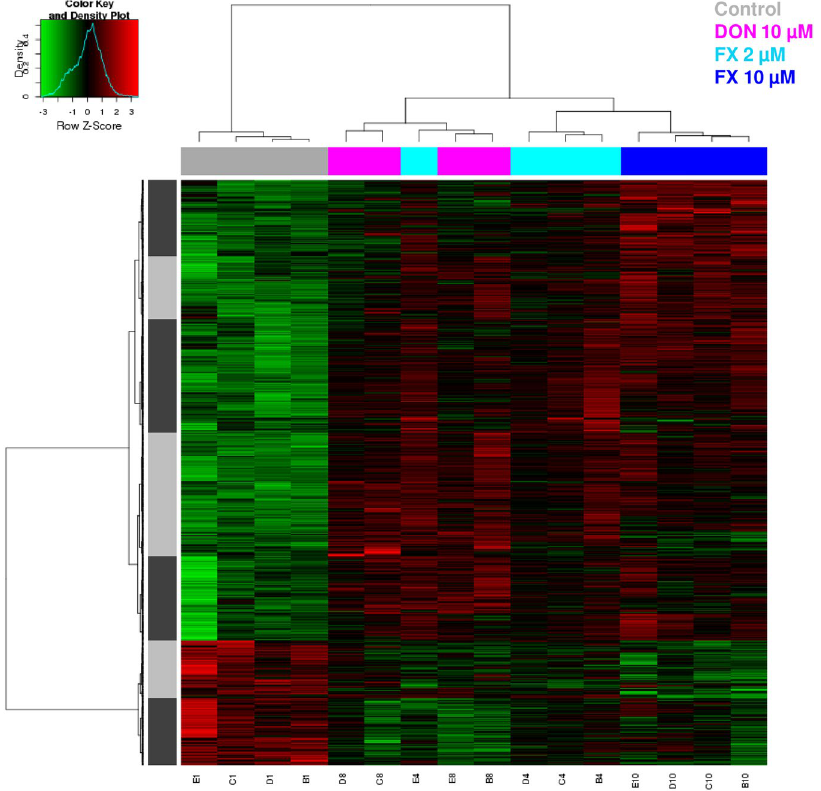
Figure 3. Gene expression profiles of intestinal explants exposed to DON or FX. Heatmap representing differentially expressed probes between the control, DON, and FX conditions. Jejunal explants from 4 different animals were exposed for 4 hours to DMSO (vehicle), 10 μ M DON (as a benchmark for the toxicity of TCTBs), or 2 or 10 µ M FX. Gene expression was analyzed with a 60 K microarray. Red and green colors indicate values above and below the mean (average Z-score), respectively. Black indicates values close to the